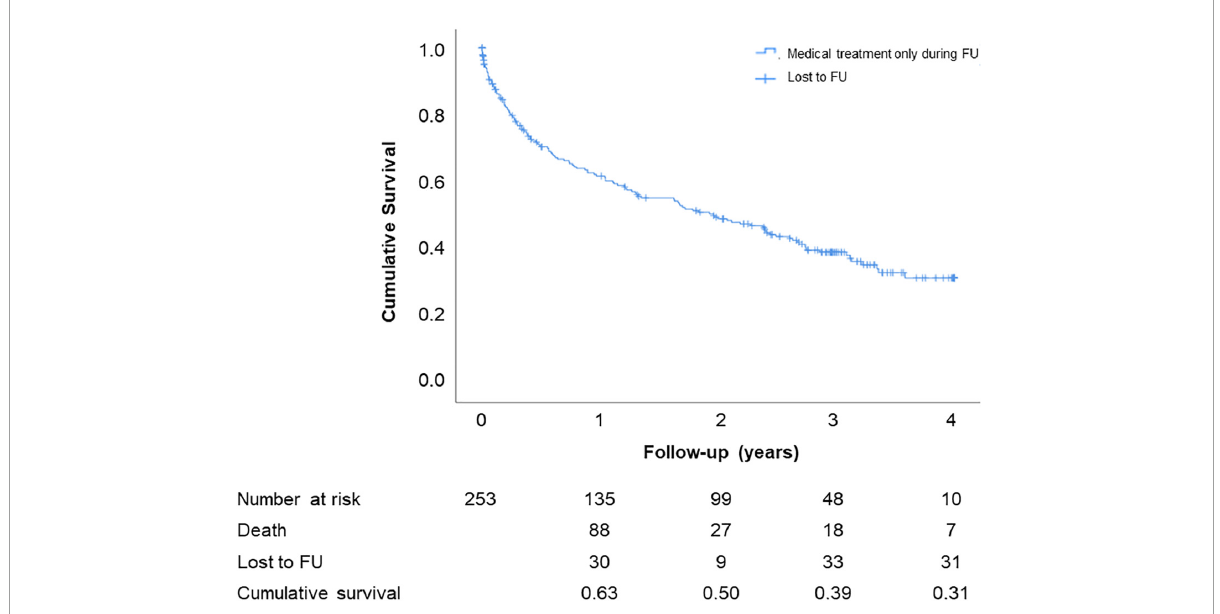
FIGURE3 Estimated cumulative survival (Kaplan–Meier curve) up to 4-year follow-up.